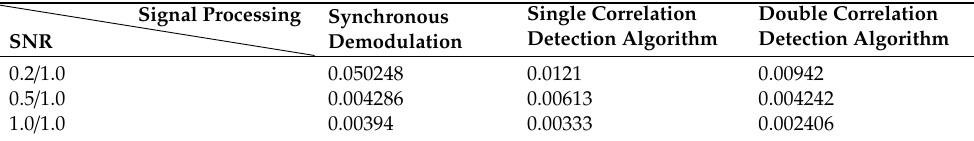
Table 1. Measurement errors of di ff erent signal processing